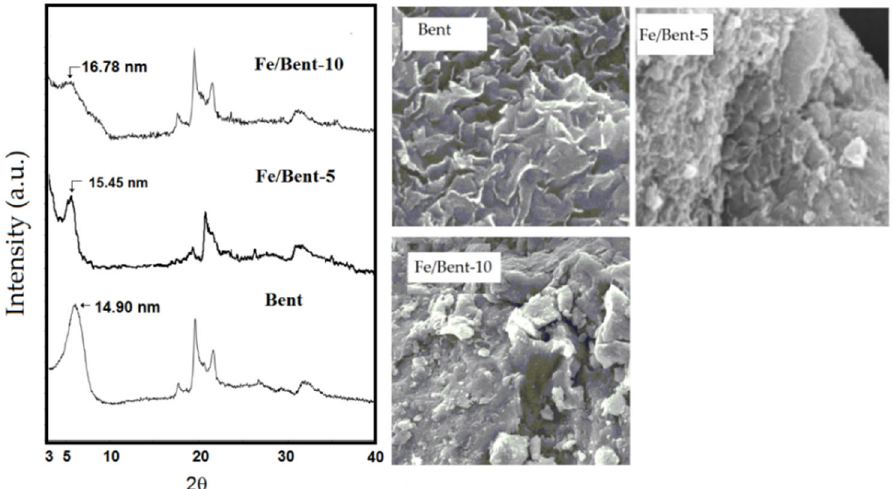
Figure 7. XRD patterns and SEM images of Fe ‐ pillared bentonite with varied Fe content (5 and 10 mmol/10 g). Adapted from Ref. [123] with permission from BCREC Group.